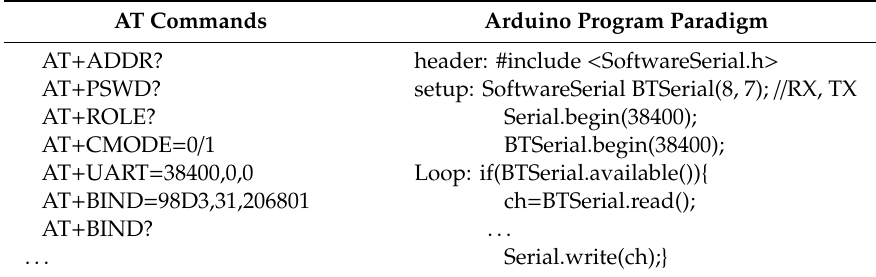
Table 3. AT Commands and Arduino program related to communication.